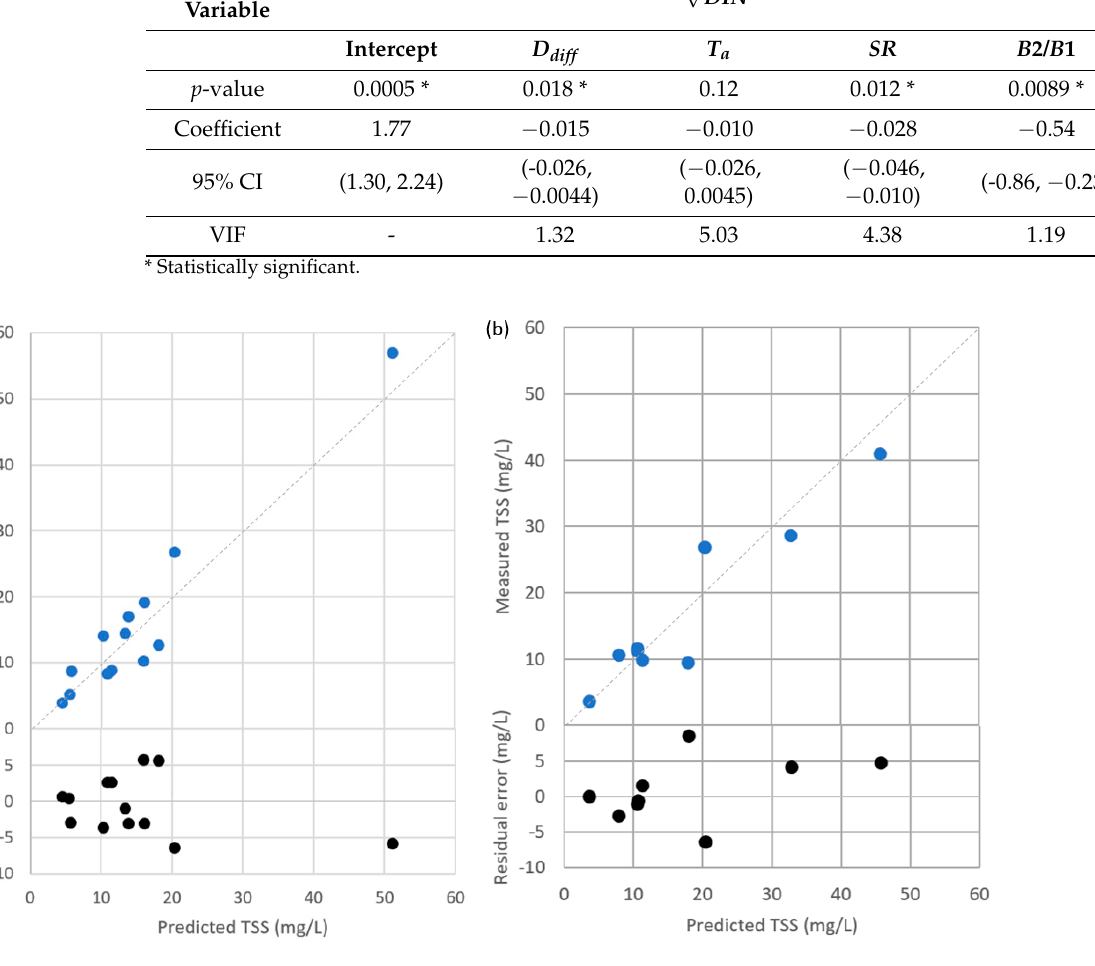
Figure 5. Scatter plots of observed and predicted TSS concentrations for ( a ) calibration and ( b ) vali- dation (1:1 line provided).